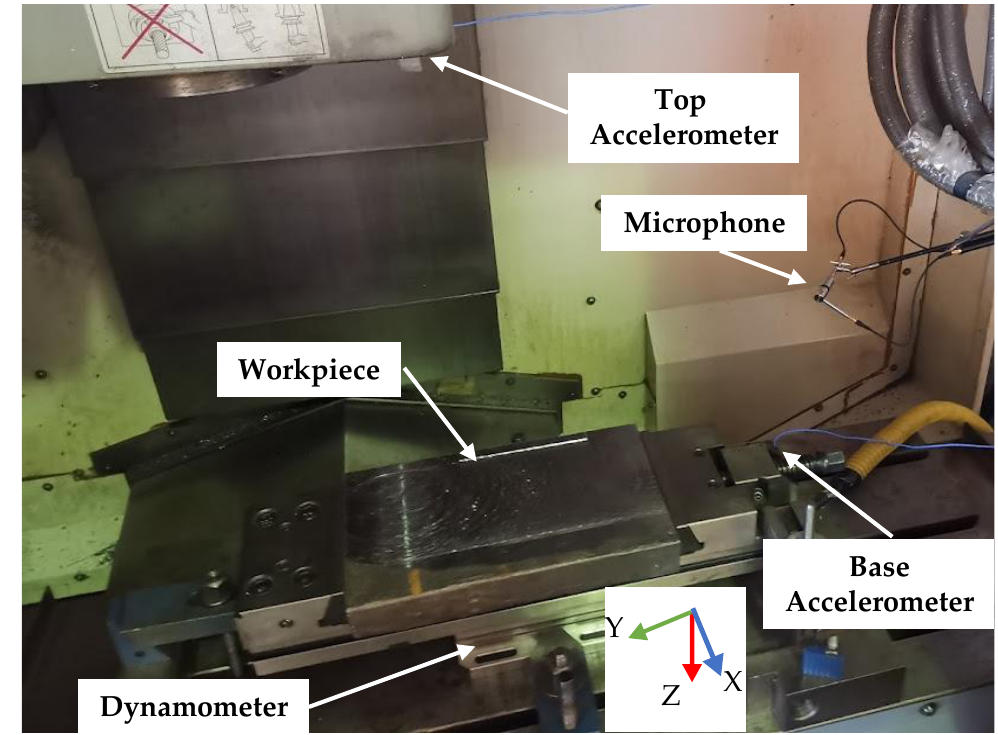
Figure 13. Experimental setup for Experiment